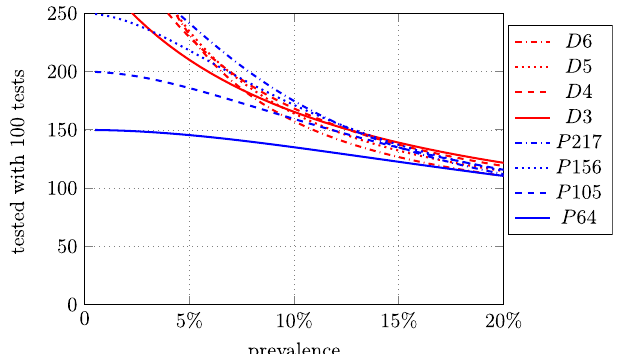
Figure 3. Average number of individuals tested with 100 tests as a function of the prevalence. Dn = Dorfman with n individuals and one pool; Pnp = protocol P with n individuals and p pools.